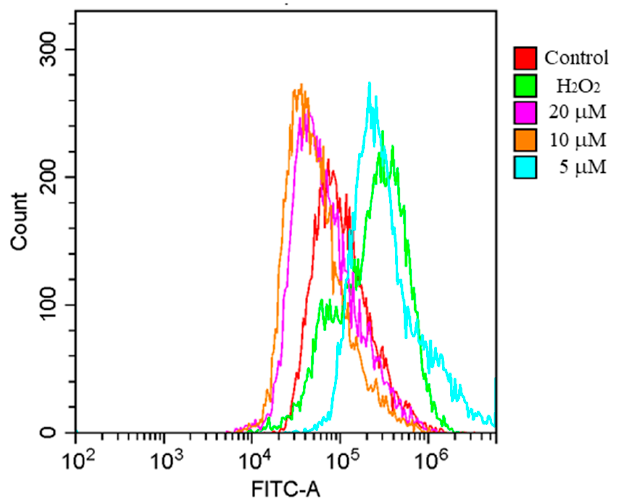
Figure 3. Effect of 1 on ROS production in PC12 cells induced by H 2 O 2 , as determined using flow cytometry. Cells were treated with various concentrations of 1 (5, 10, 20 μ M) combined with H 2 O 2 ( 750 μ M); control group is treated with 0.5% dimethyl sulfoxide (DMSO) for 24 h.